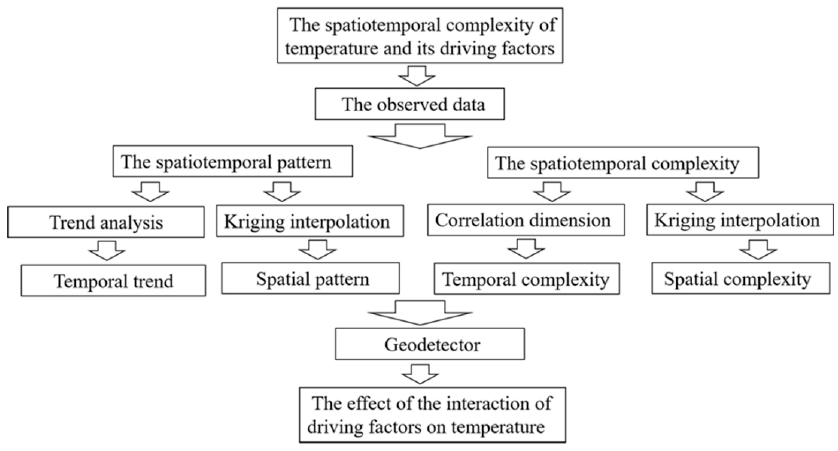
Figure 3. The framework of this study.